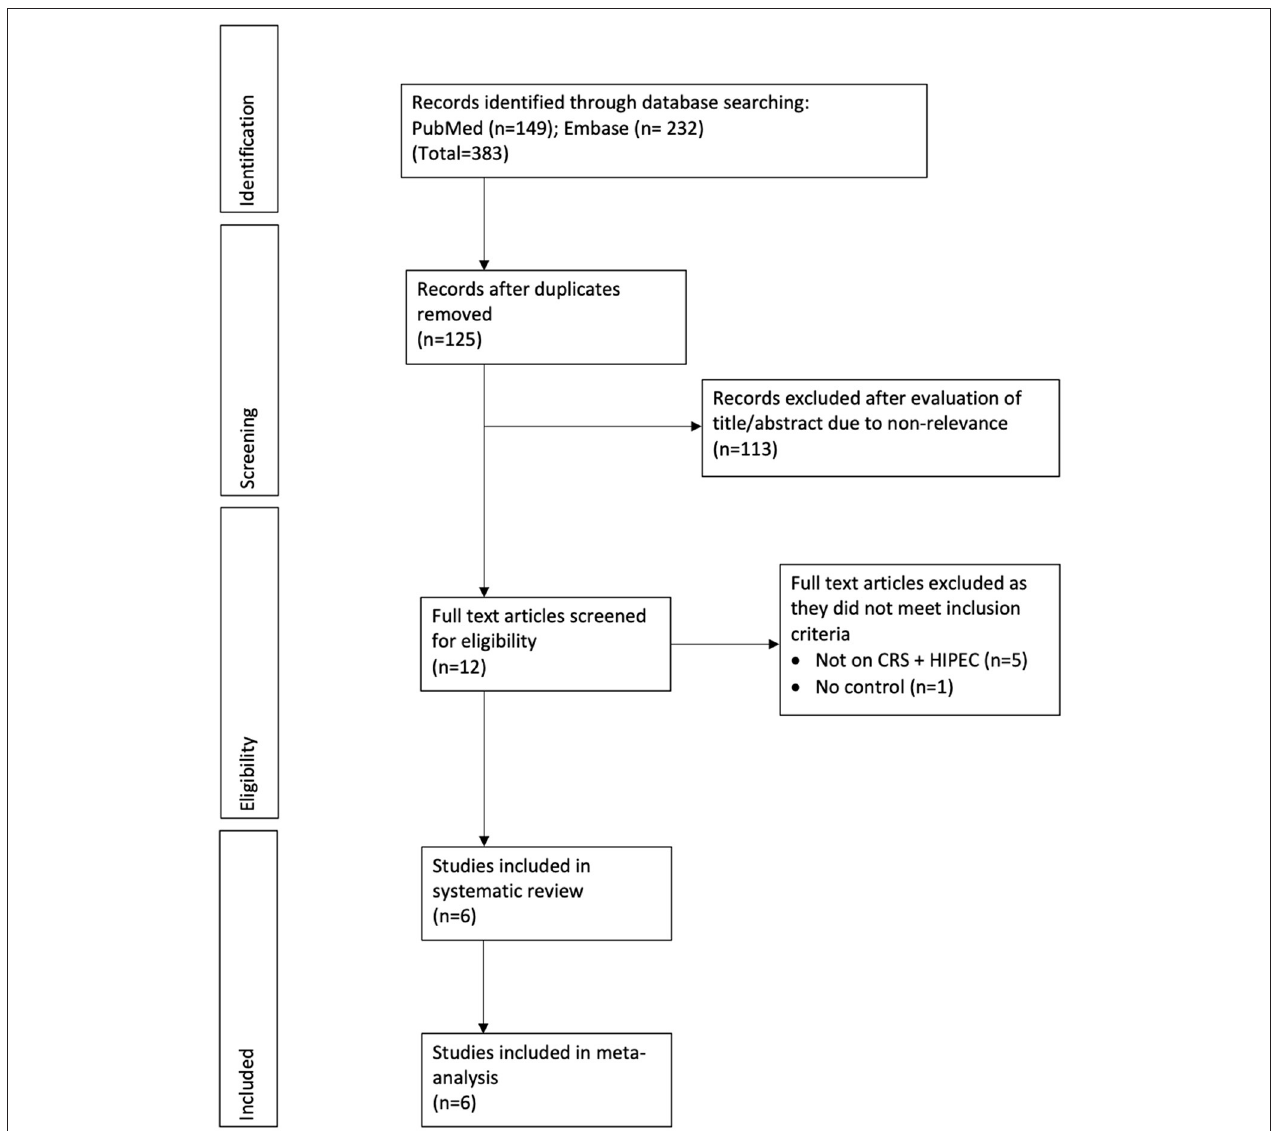
FIGURE 1 | Study flow